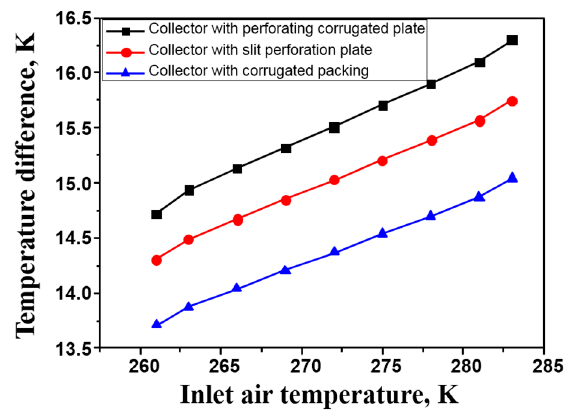
Figure 8. Effects of inlet air temperature on the temperature difference.